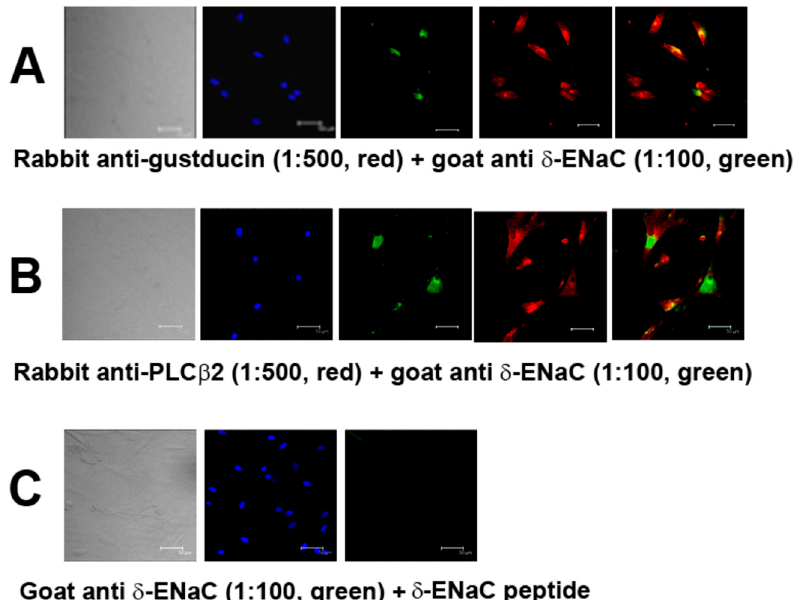
Figure 1. δ -ENaC positive HBO cells: ( A , B ) co-localization of δ -ENaC in gustducin-positive ( A ); and PLC β 2-positive ( B ) HBO cells; ( C ) peptide inhibition of δ -ENaC antibody binding to HBO cells. Left panels transmitted images: blue 4 ′ ,6-diamidino-2-phenylindole (DAPI) stained cell nuclei; green δ -ENaC antibody binding; red gustducin or PLC β 2 antibody binding. Scale bar = 50 µm.